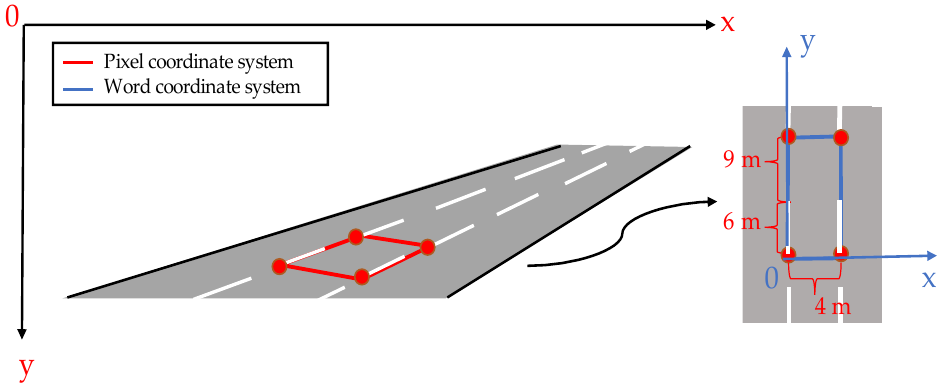
Figure 3. Calibration of the coordinate system transformation matrix.